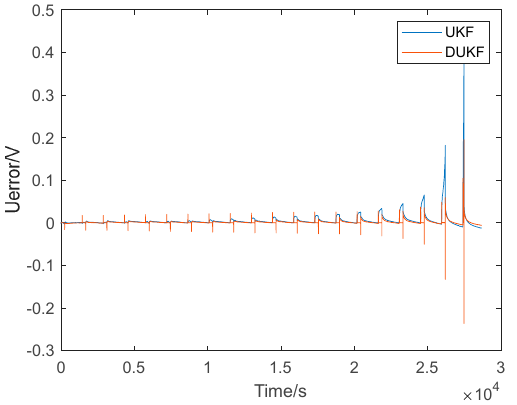
Figure 10. The error curves of UKF and DUKF .